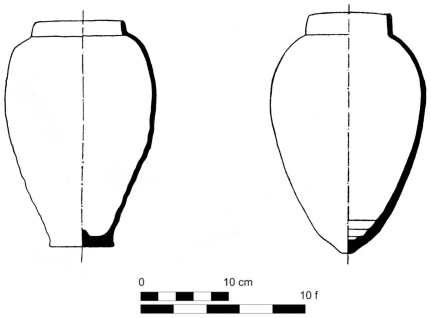
Typical Egyptian beer jars [13, Plate IX b, jars 28 and 24].